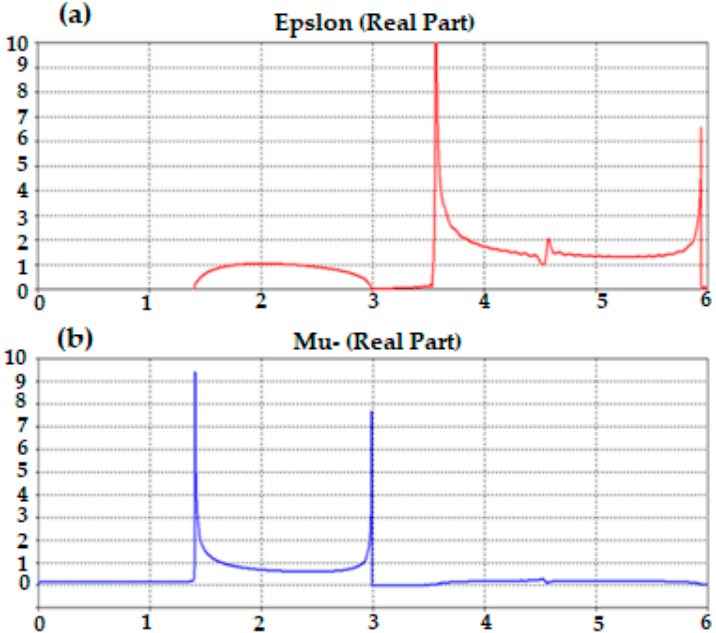
Figure 4. Moore unit cell electromagnetic properties: ( a ) Permittivity and ( b ) Permeability.